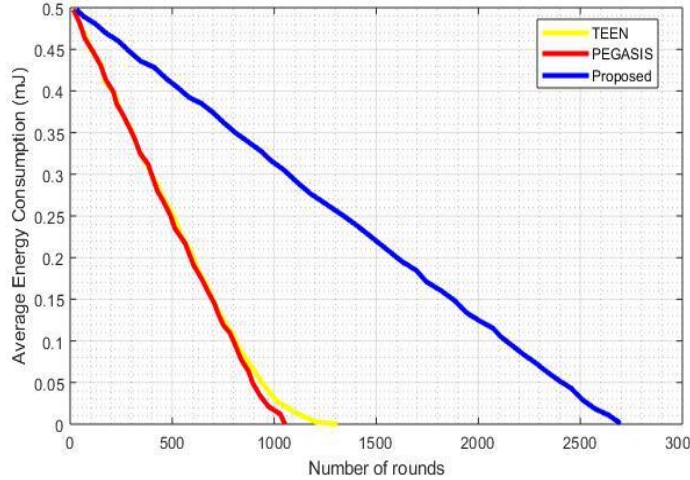
Figure 6. Energy consumption with 100 nodes.